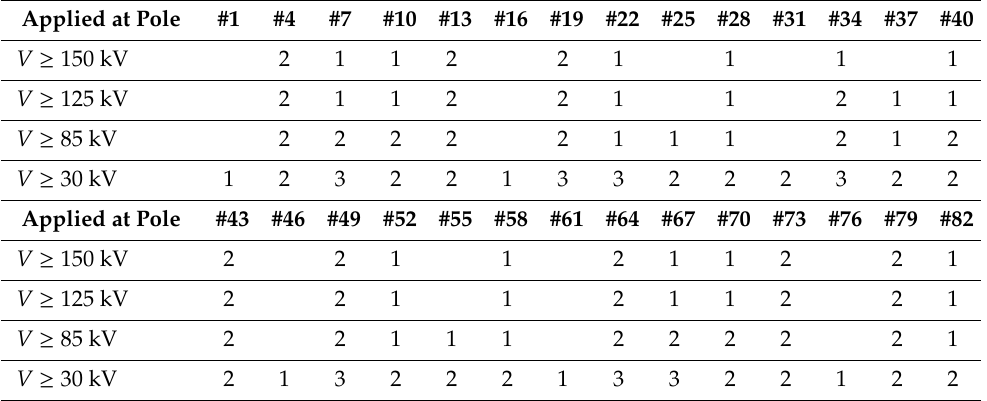
Table 11. Number of transformers with at least one phase reaching the critical overvoltage level. Case 4, wet creosote-impregnated poles, sub-configuration C4.1 with no grounded intermediate poles. Applied at Pole #1